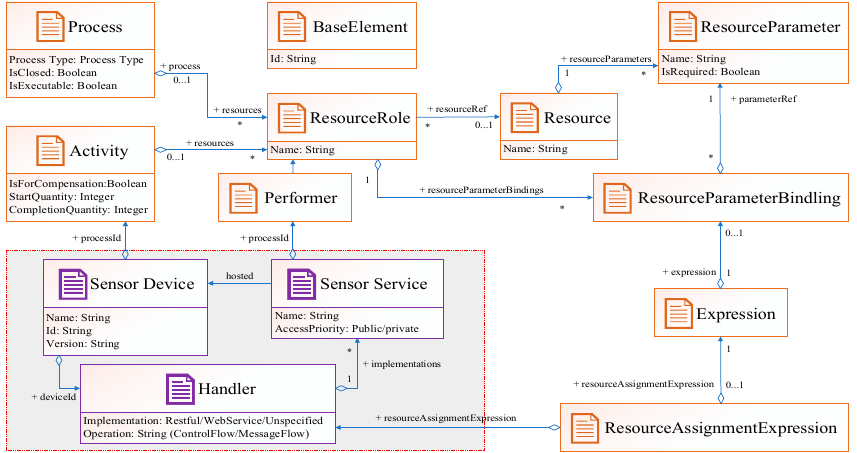
Figure 2. Sensor-aware specific class extension of the XML schema definition (XSD) specification of Business Process Model Notation (BPMN) 2.0.